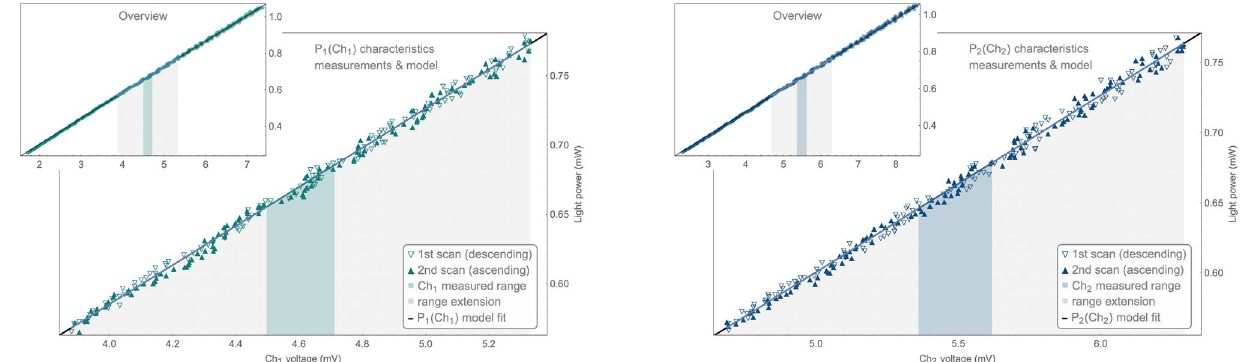
Figure 4. Example of linear approximation of both characteristics along with source measurements. The colored vertical stripe indicates the range of the detected voltage variability in the cycle. The grey vertical stripes indicate an additional range (up to 25% ) of the points used to determine the linear